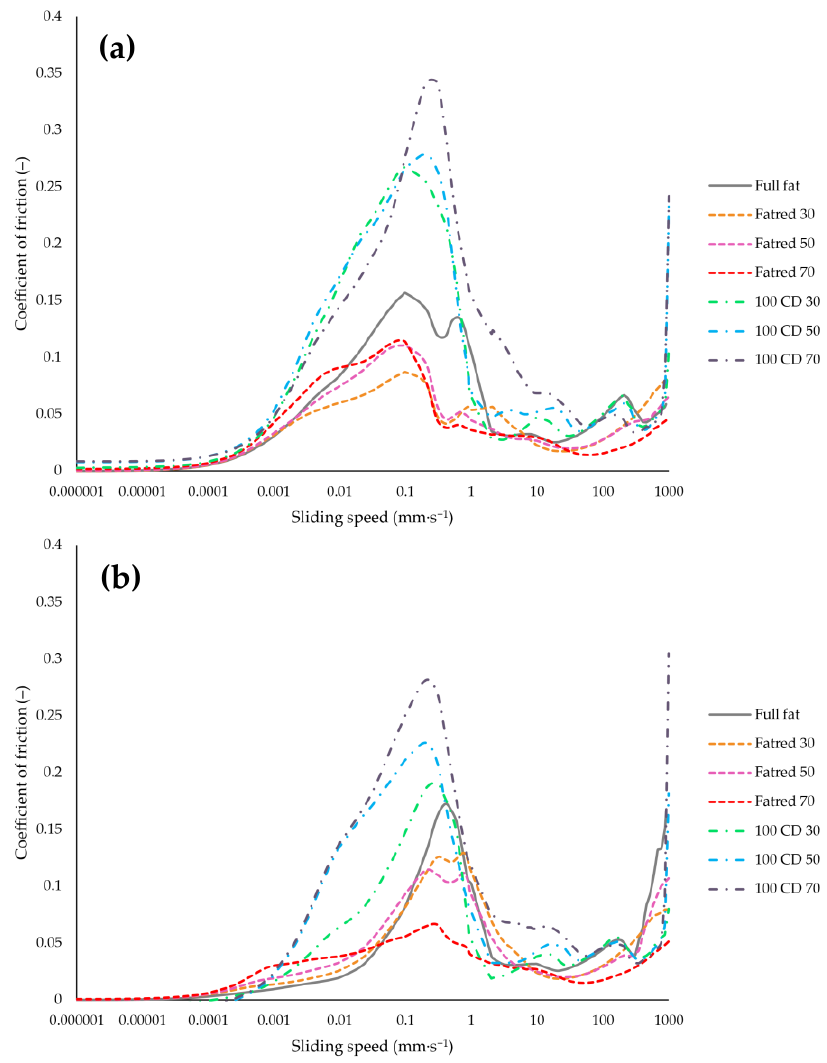
Figure 7. Stribeck curve 1 ( a ), curve 2 ( b ), and curve 3 ( c ): coefficient of friction versus sliding speed of PCS samples with different fat contents. The curves are mean values of all four measurements per each